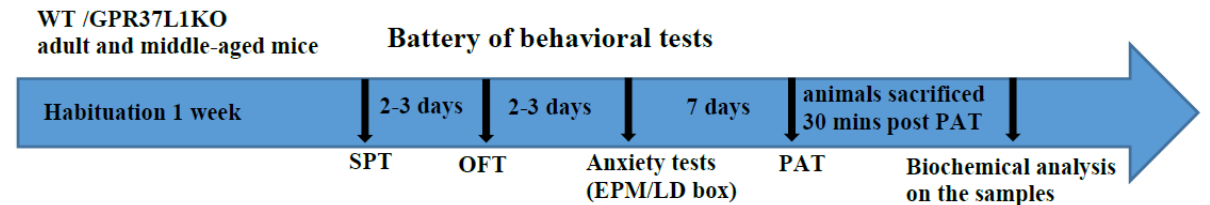
Figure 1. Schematics of the study show the timelines of the behavioral tests conducted in adulthood and in middle-aged WT and GPR37L1KO mice. SPT = Sucrose Preference Test, OFT = Open-Field Test, EPM = Elevated Plus Maze, LD box = Light Dark Box, PAT = Passive Avoidance Task.